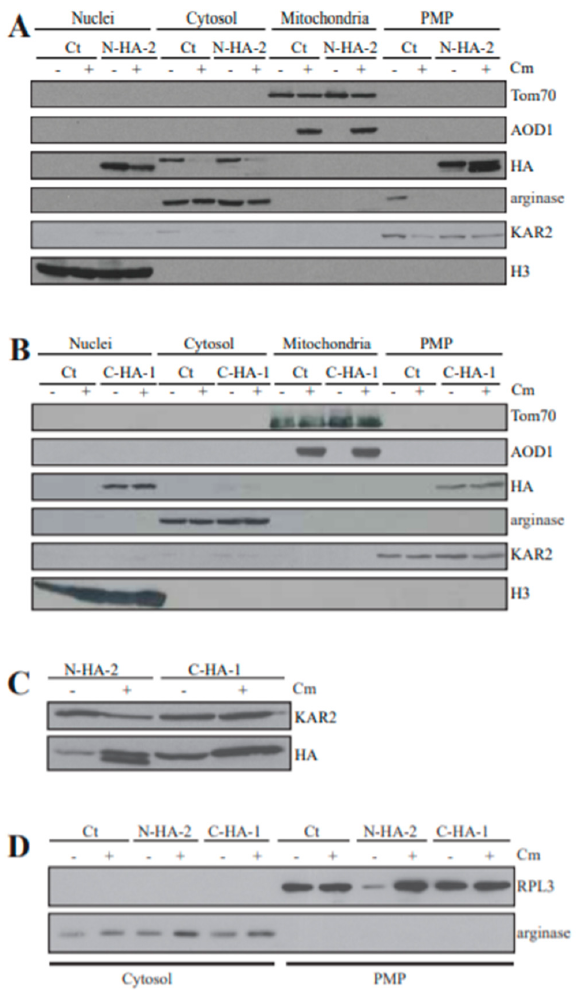
Figure 5. Subcellular localization of the YVH1 protein. ( A , B ) Western blot analysis of subcellular fractionation experiments from N- and C- terminal 3xHA tagged YVH1 strains (N-HA-2 and C-HA- 1, respectively) and the control (ct) strain NCN251. Nuclei, cytosol, mitochondria, and Post- Mitochondrial Pellet (PMP) fractions were isolated from the N-HA-2 ( A ) and C-HA-1 ( B ) tagged YVH1 transformants as well as the control strain (NCN251) as described in the Material and Methods. Cultures were grown in the absence ( − ) or presence (+) of Cm for 20 h. Proteins were separated by SDS-PAGE, blotted to nitrocellulose membrane and probed with the antibodies indicated on the right. Antibodies that served as indicators to identify the different fractions were Tom70, as a mitochondrial marker [62] ; arginase as a cytosolic marker [68] ; the ER protein KAR2 as a microsomal marker in the PMP [69] ; and Histone 3 (H3) as a nuclear marker. Antibody against the HA tag detects the YVH1 protein. ( C ) Comparative Western blot analysis of the HA tagged bands in the PMP fraction of the N- HA-2 and C-HA-1 transformants. PMP fractions were isolated from N-HA-2 and C-HA-1 grown in the absence ( − ) or presences (+) of Cm. Proteins were separated by SDS-PAGE, blotted to a nitrocellulose membrane, and probed with the antibodies indicated on the right. ( D ) Ribosomal proteins are found in the PMP fraction. Western blot analysis of cytosol and PMP fractions from the fractionations shown in panels A and B. Proteins were separated by SDS-PAGE, blotted to nitrocellulose membrane and probed with the antibodies indicated on the right. An S. cerevisiae RPL3 antibody was used as a ribosomal protein marker. Ct, control strain NCN251. The N-terminal tagged version of YVH1 that was present in the PMP fraction appeared as two bands of slightly different molecular size following growth in Cm (Figure 5A). Direct comparison of the N- and C-tagged proteins of the PMP fraction on the same gel confirmed that the larger molecular